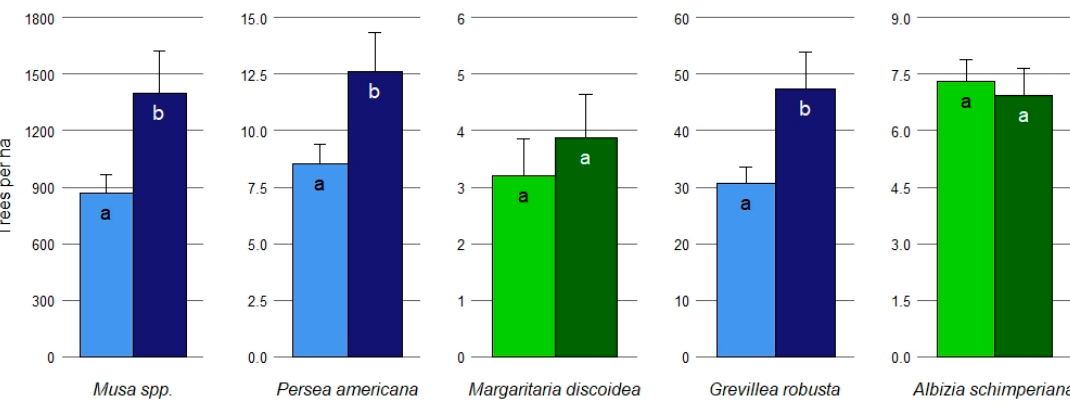
Figure 6. Average ( + SE) plant density of the five highest ranked tree species providing the services food, fodder and firewood. The dark bars show respondents who selected the three ESs as the three most important for their family, while the light bars indicate the plant density for respondents who did not select all three. Significant di ff erence between plant density is shown by di ff erence in letters (a and b) ( p < 0.05). Blue bars represent exotic, and green bars indigenous